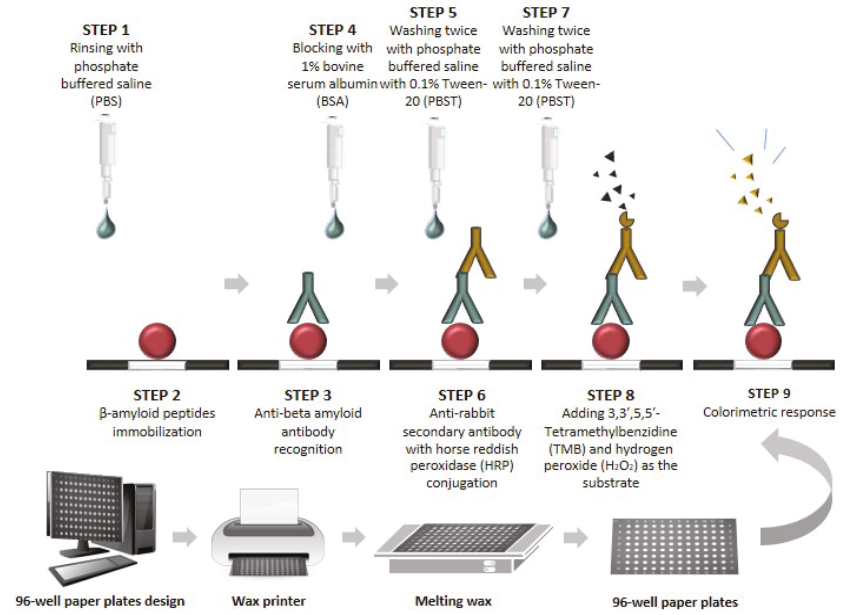
Scheme 1. Schematic of our paper-based ELISA (P-ELISA) device development and test procedure for the detection of β -amyloid peptide 1-42 (A β 42) concentrations in both bu ff er and plasma systems.